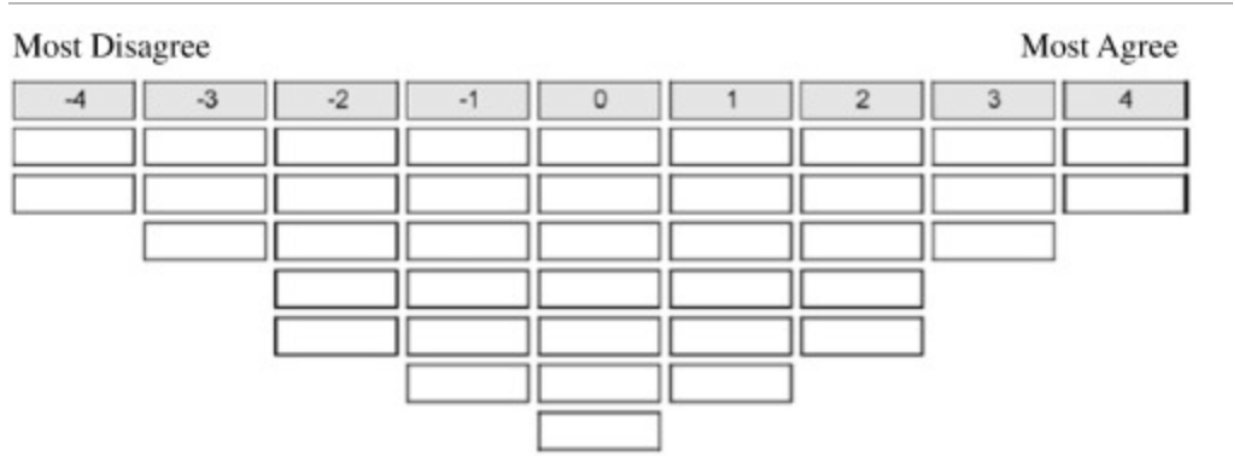
Figure 4. Sample Q–grid.